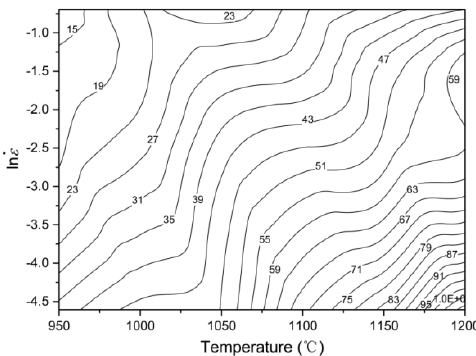
Figure 11. Contour map representing isograin size contours (marked as μm) of the deformed samples of 30Cr2Ni4MoV steel.